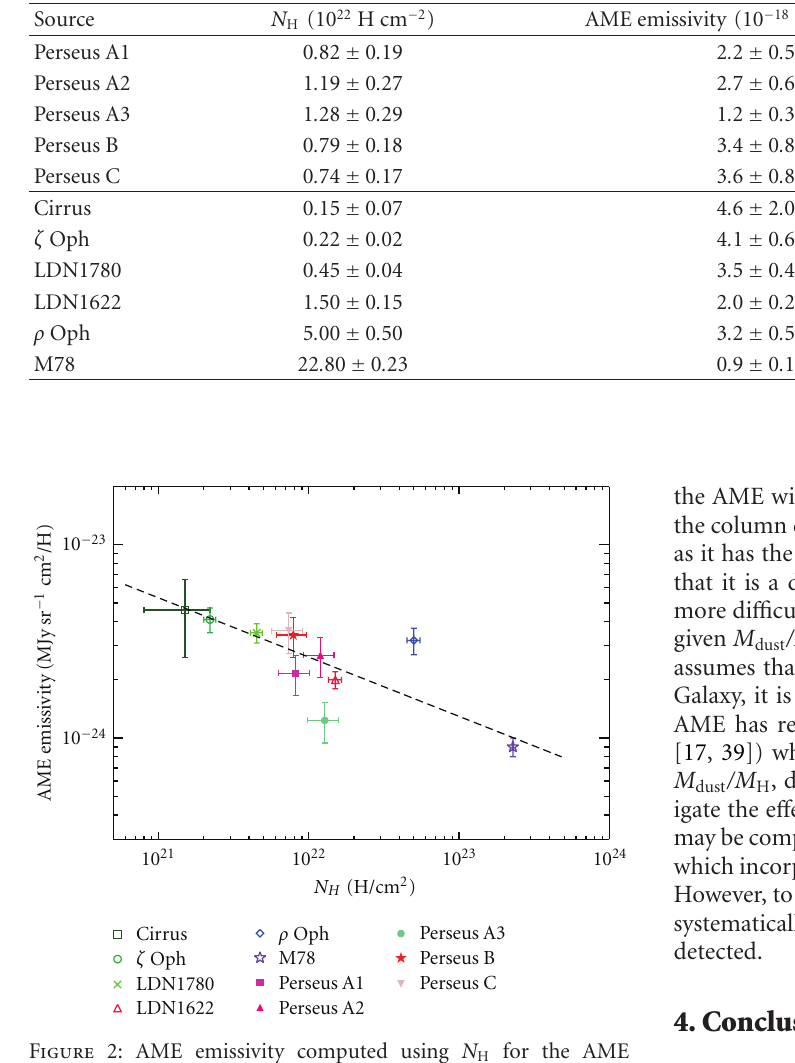
Figure 2: AME emissivity computed using N H for the AME detections listed in Table 2 plotted as a function of N H . Also plotted is the fit to the data (dashed line), which we estimate to have a spectral index of − 0 . 31 ± 0 .